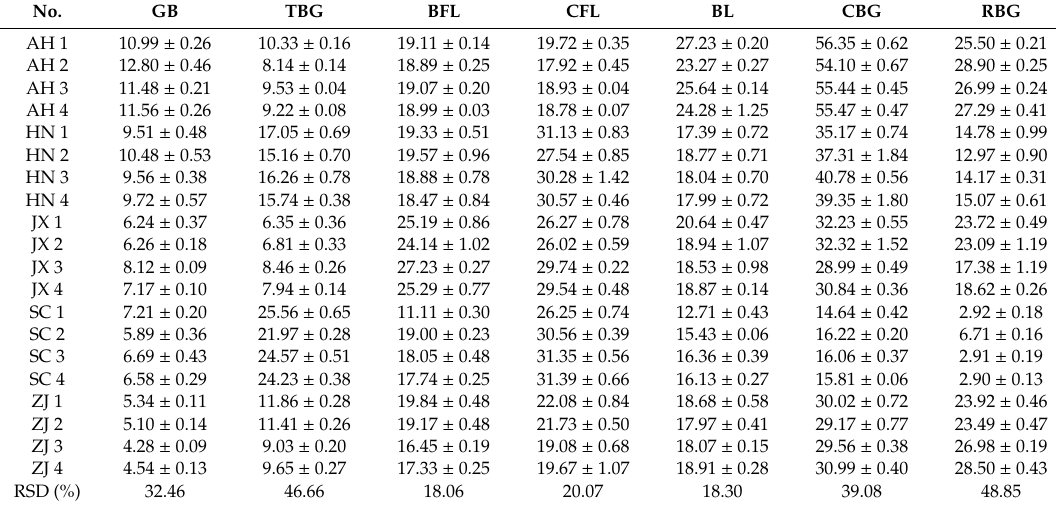
(Table 2). The Kruskal–Wallis test also indicated the samples from the di ff erent origins had significant di ff erences ( p < 0.01). Table 2. The contents (mg / g) of the seven bufogenins in 20 batches of Chansu samples from di ff